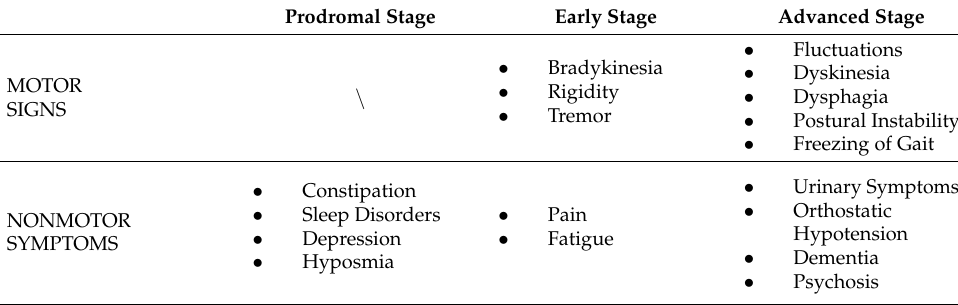
Table 1. Clinical features of Parkinson’s